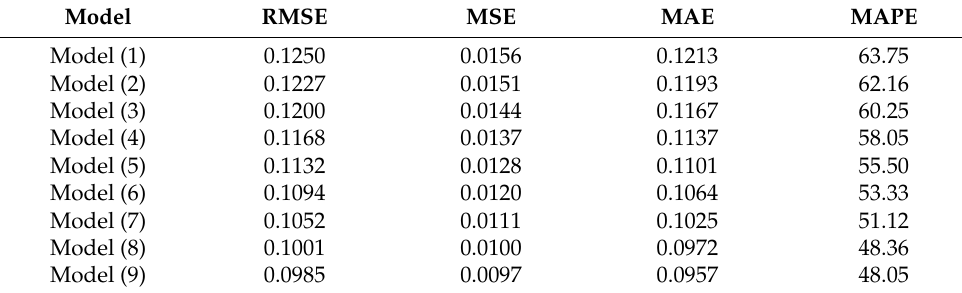
Table 4. Evaluation the level of uncertainty for trapezoidal IT2 MF. Model